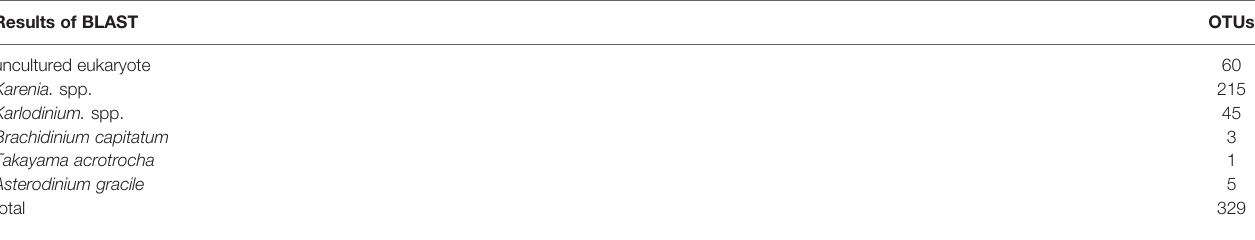
TABLE 8 | BLAST results of representative sequences of 329 OTUs with the identity less than 90%. Results of